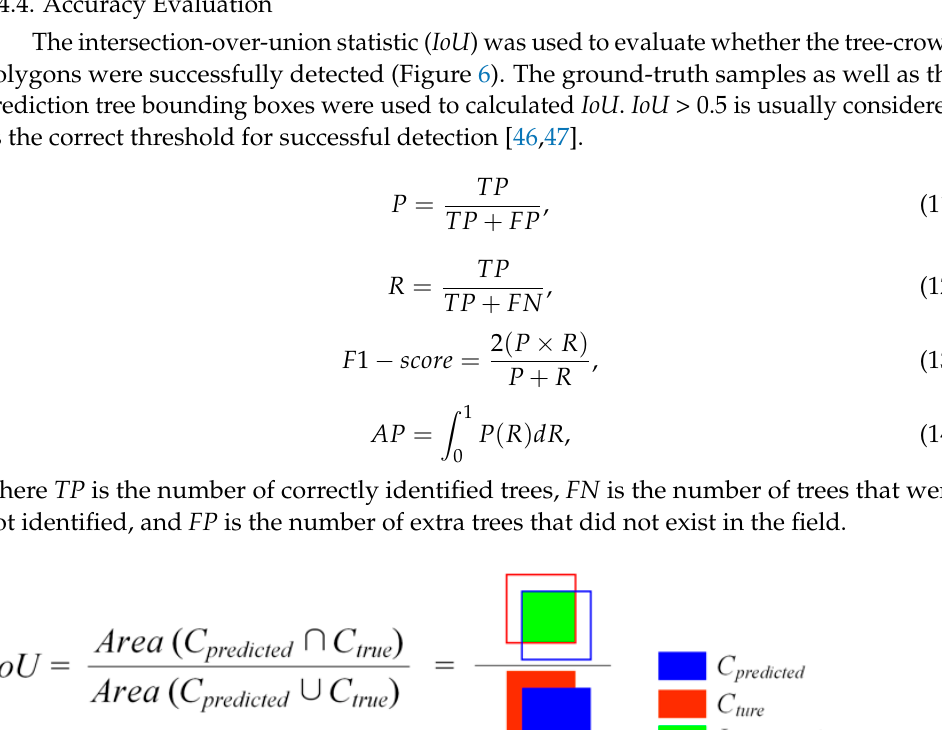
identified trees. R is the individual tree identification rate, which is the ratio between the number of